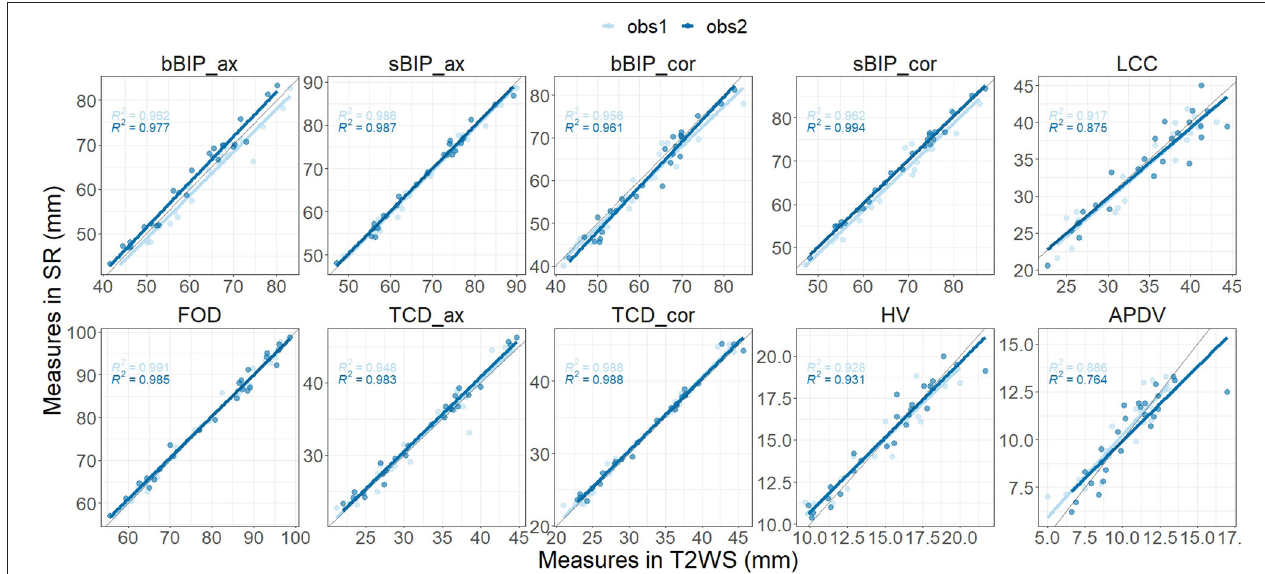
FIGURE 4 | Inter-dataset [T2-weighted sequence (T2WS) vs. super-resolution (SR)] agreement for observer 1 and for observer 2 for each biometric measurement. For each biometric, measurements on SR (vertical y-axis) and on T2WS (horizontal x-axis) for each fetal brain MRI examination (point) for observer 1 (light blue) and observer 2 (dark blue). The solid gray line depicts perfect